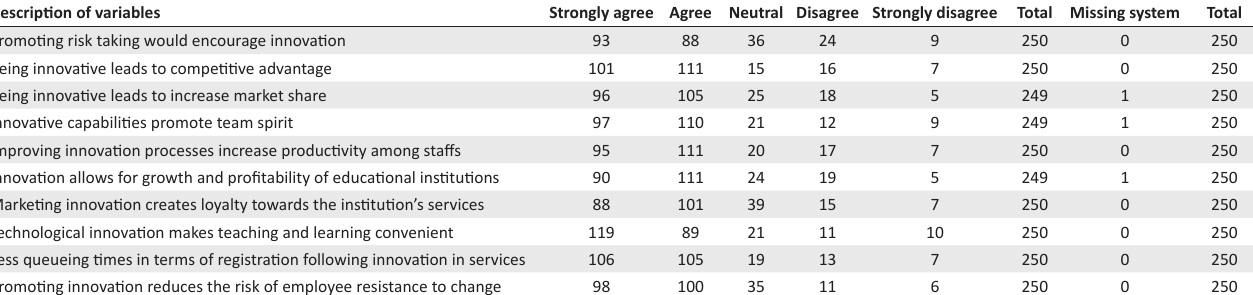
TABLE 6: Using only frequencies.